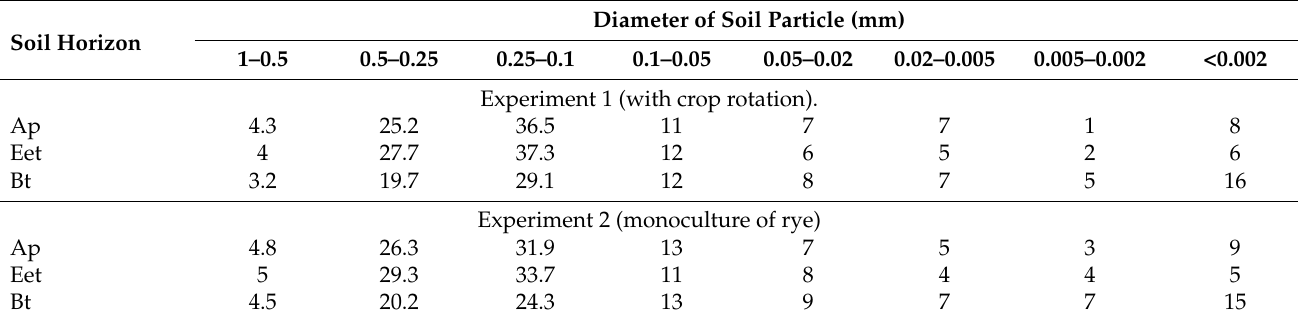
Table 1. Content of soil particles of various sizes in